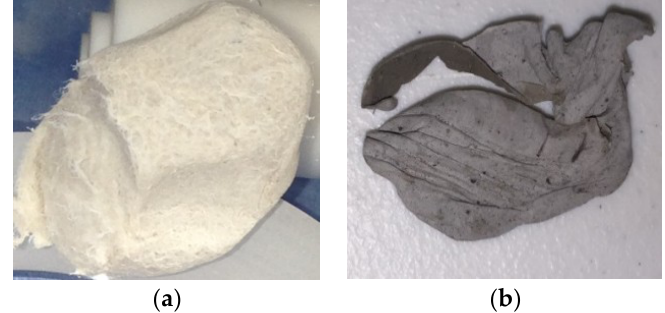
Figure 16. Photographs of BNNT nanomaterials from ( a ) BNNT, LLC, and ( b ) BNNano.